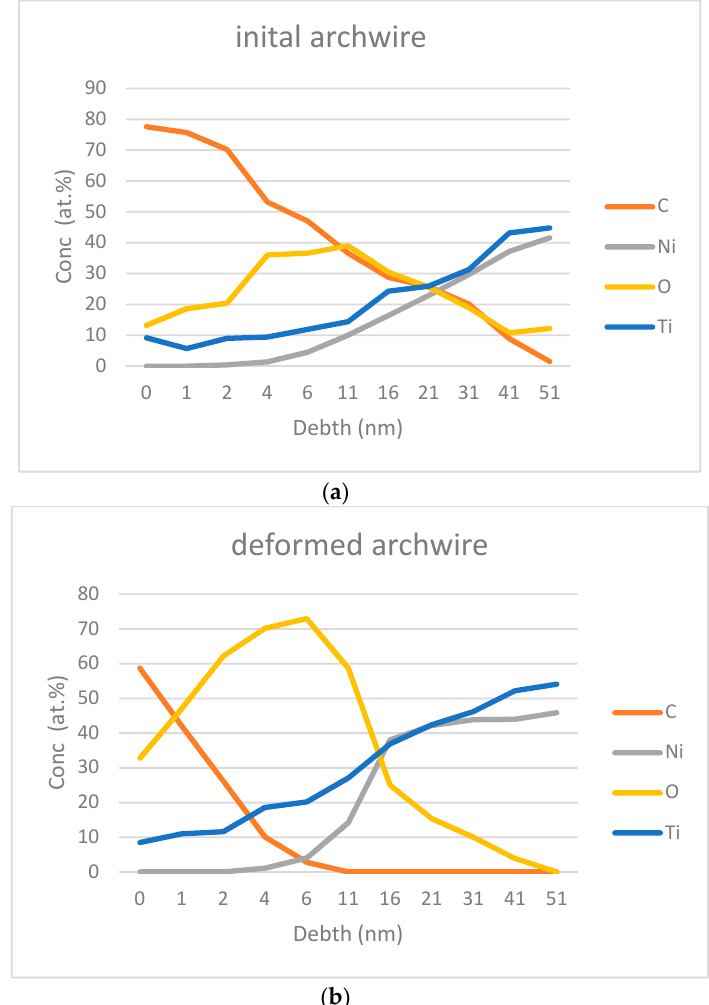
Figure 5. AES depth profiles show the concetrations of elements in the direction from the surface to 51 nm in the depth of each of the archwires: ( a ) Initial (control), ( b ) Deformed after the SMAS simulation